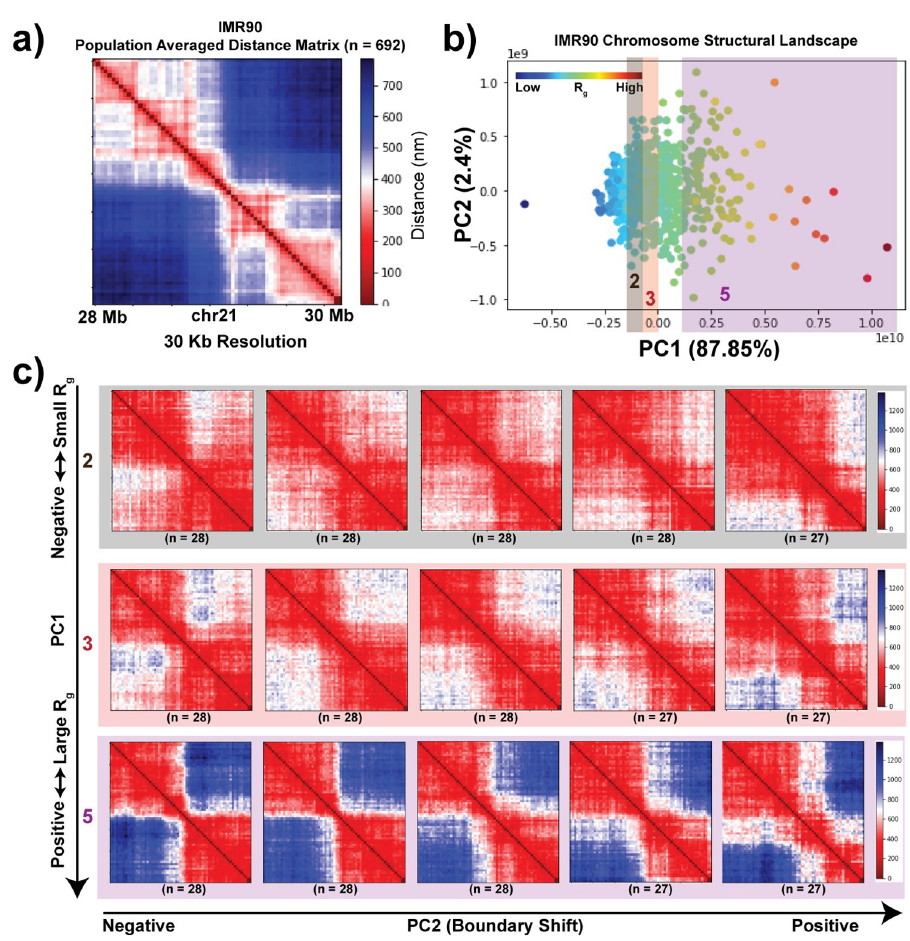
Fig 2. The chromosome structural landscape orders single-cell structures on a continuum based on their radius of gyration followed by domain reorganization. a) Population-averaged distance map of IMR90 chr21:28–30 Mb at 30 kb resolution. b) Chromosome structural landscape of IMR90 chr21:28–30 Mb chromatin region, generated as described in the Methods section. Each point represents a single-cell structure. Points are colored according to the radius of gyration ( R g ) of the corresponding structures (dark blue–smaller R g and dark red–larger R g ). The percent of variation explained by each PC is shown in parentheses. c) Structures are first divided into five groups based on the PC1 ordering (which correlates highly with R g ). Structures belonging to groups 2, 3 and 5 are shown. Within each group structures are further divided into five subgroups based on their PC2 ordering. Average structures within each subgroup are